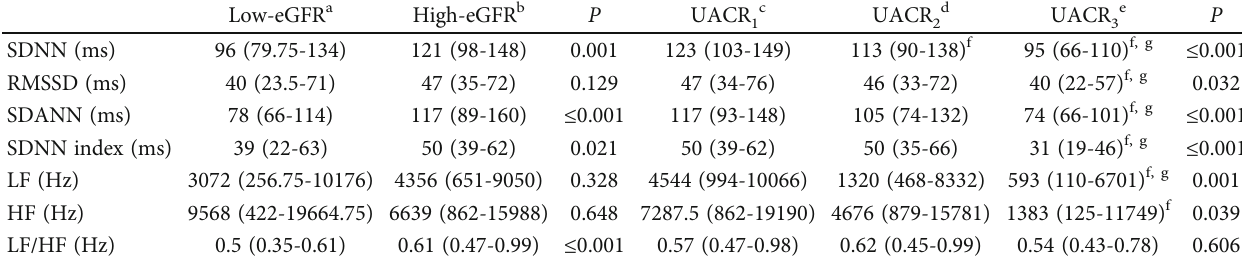
Table 2: HRV parameters in T2DM strati fi ed by eGFR and UACR